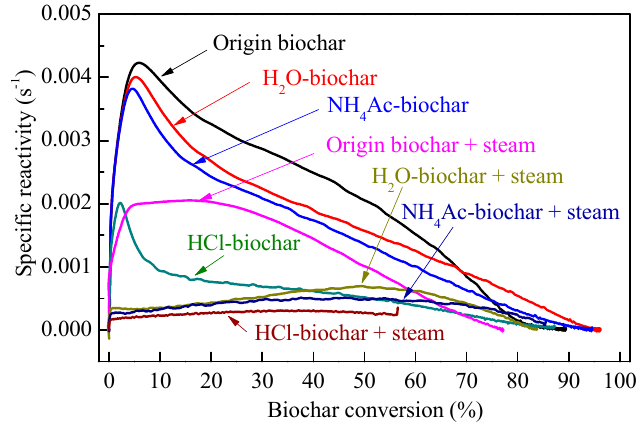
Figure 10. Specific reactivity of biochar samples as a function of biochar conversion.